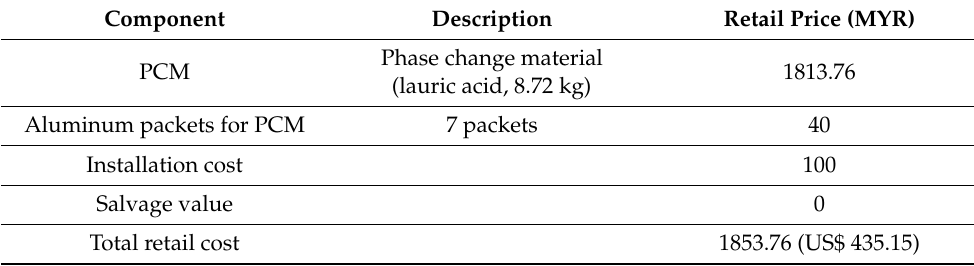
Table A2. The breakdown cost of PCM.